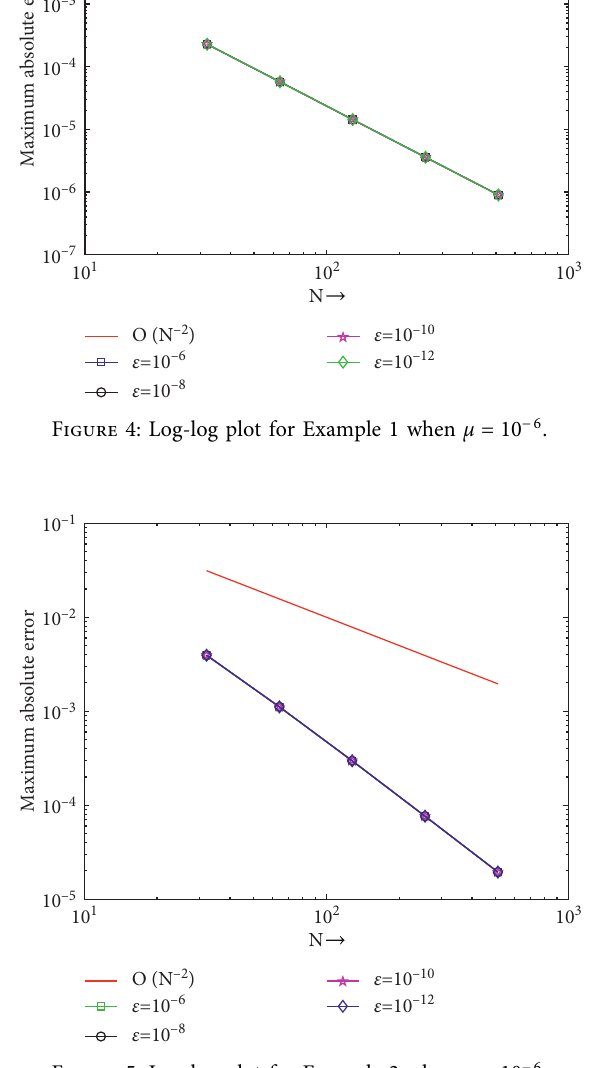
Figure 5: Log-log plot for Example 2 when μ � 10 − 6